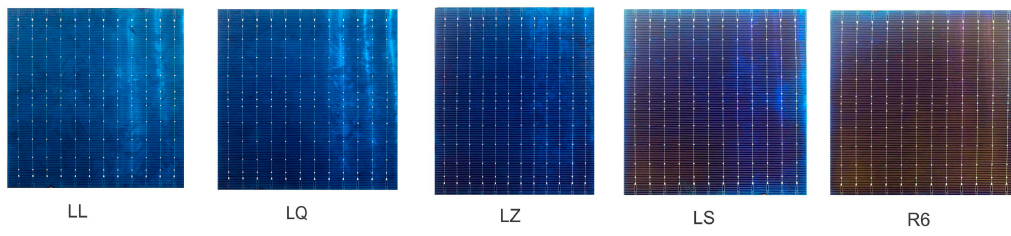
Figure 1. Polycrystalline silicon cells of different color categories.